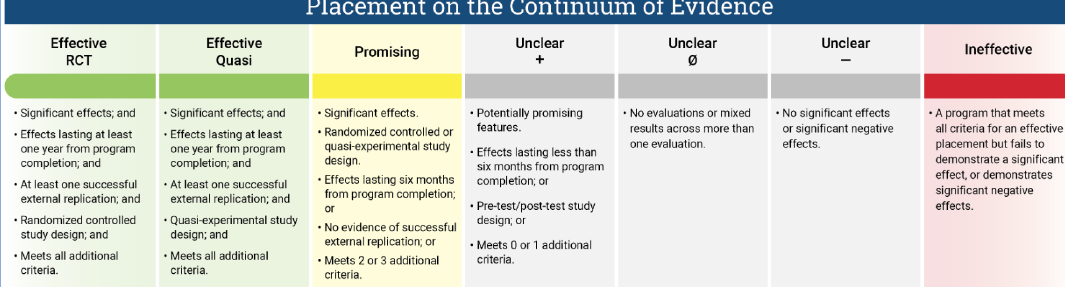
Figure 1. Clearinghouse Program Effectiveness Continuum Descriptions